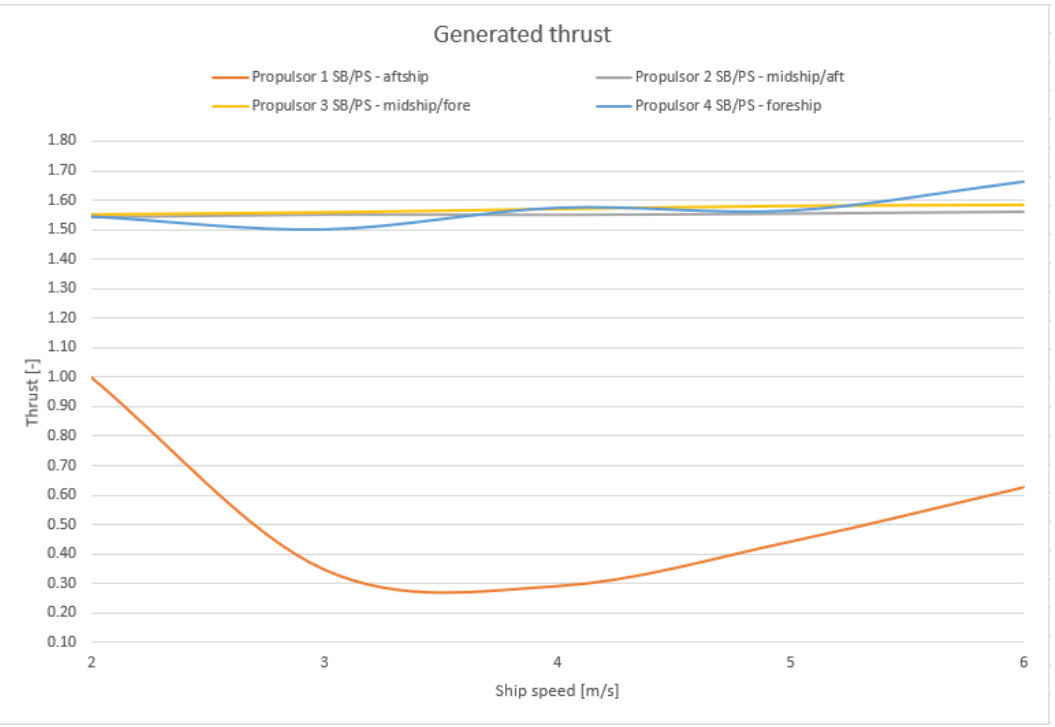
Figure 12. Propulsion thrust, shallow water (layout E). Source: Authors. J. Mar. Sci. Eng. 2020 , 8 , x FOR PEER REVIEW